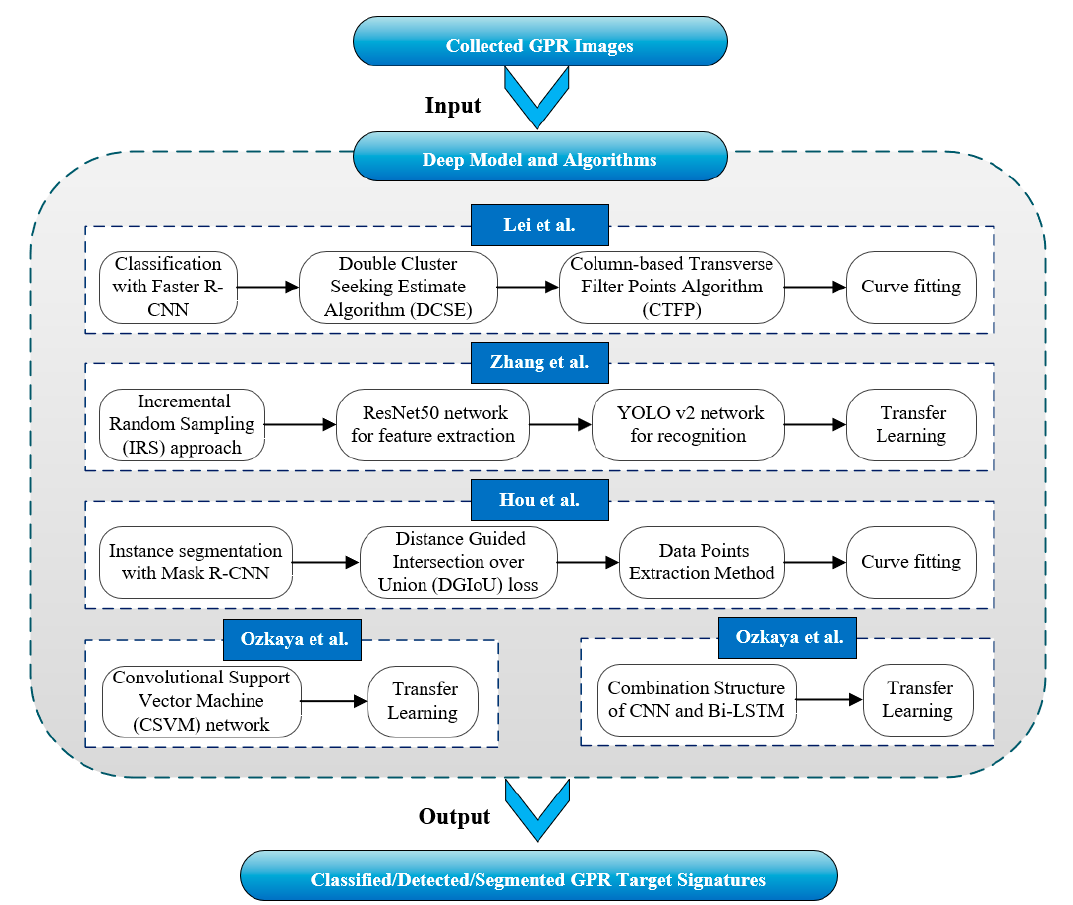
Figure 4. Diagram of some significant deep models and algorithms [15,19–22].